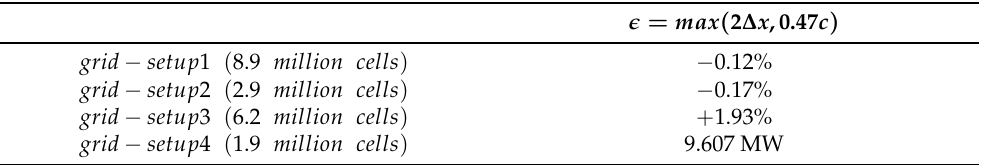
Figure 11. Wind turbine hexa grid setup. Table 5. Variaton of power [MW] with different grid setup. Reference power corresponds to grid “setup4”